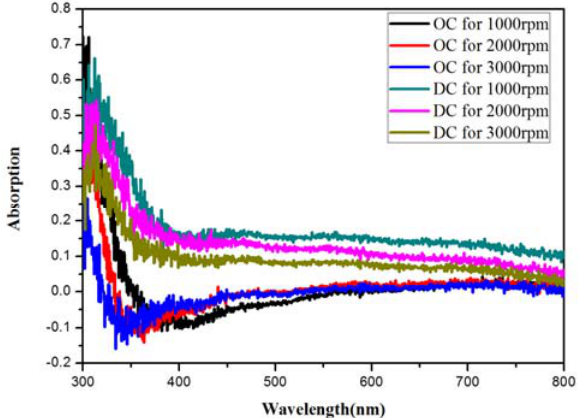
Figure 3. The external quantum efficiency (EQE) spectrum of best device from 300 to 800 nm. The black curve is device obtained by OC TiO 2 and red curve is device obtained by DC TiO 2 .